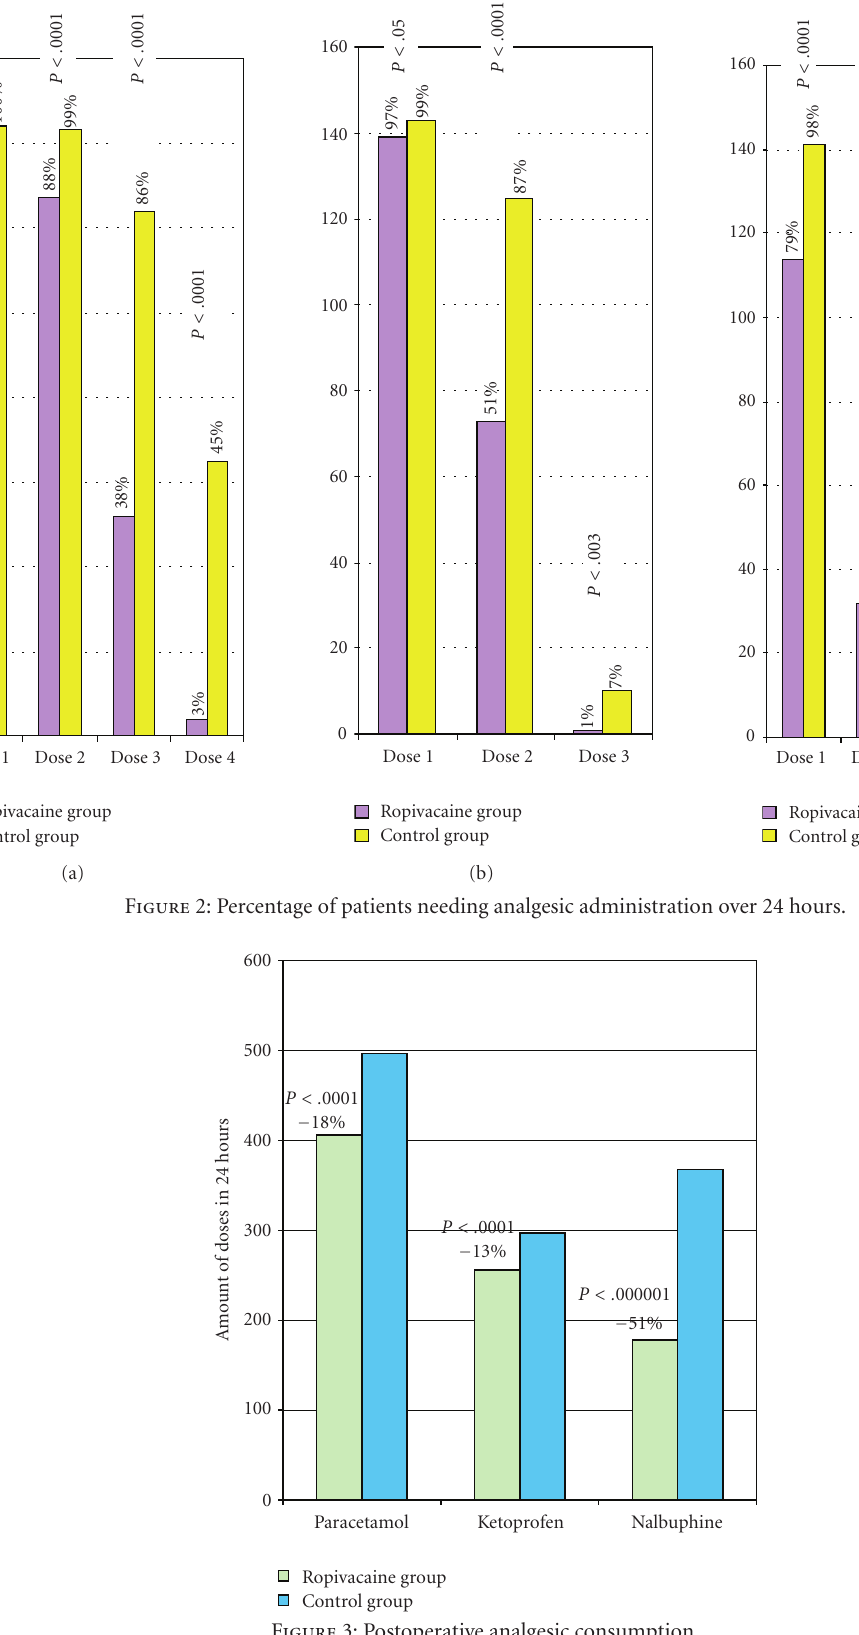
Figure 3: Postoperative analgesic